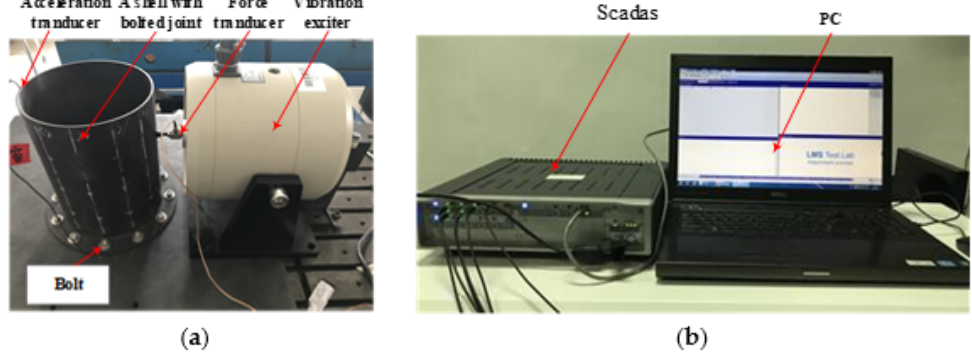
Figure 7. Experimental test set up. ( a ) The test subject and ( b ) the Simcenter Testlab system. In this case, the Simcenter Testlab system is applied to obtain the input and output signals under different design parameter values of the bolted joint cylinder for verification of the WEFOR algorithm. Denote the input (force) and output (acceleration) variables using u ( t ) and y ( t ), respectively. The pre-tightening torque of the bolts is chosen to be the design parameter, which denotes as δ in this section. Five data sets of 40,000 sample points corresponding to the design parameter δ = [2, 4, 6, 7, 8] Nm were sampled as the input and the output signals. The signals of δ = [2, 4, 6] Nm are used for modeling, and the signals of δ = [7, 8] Nm are used for the modification and validation. The test data sets are shown in Figure 8.